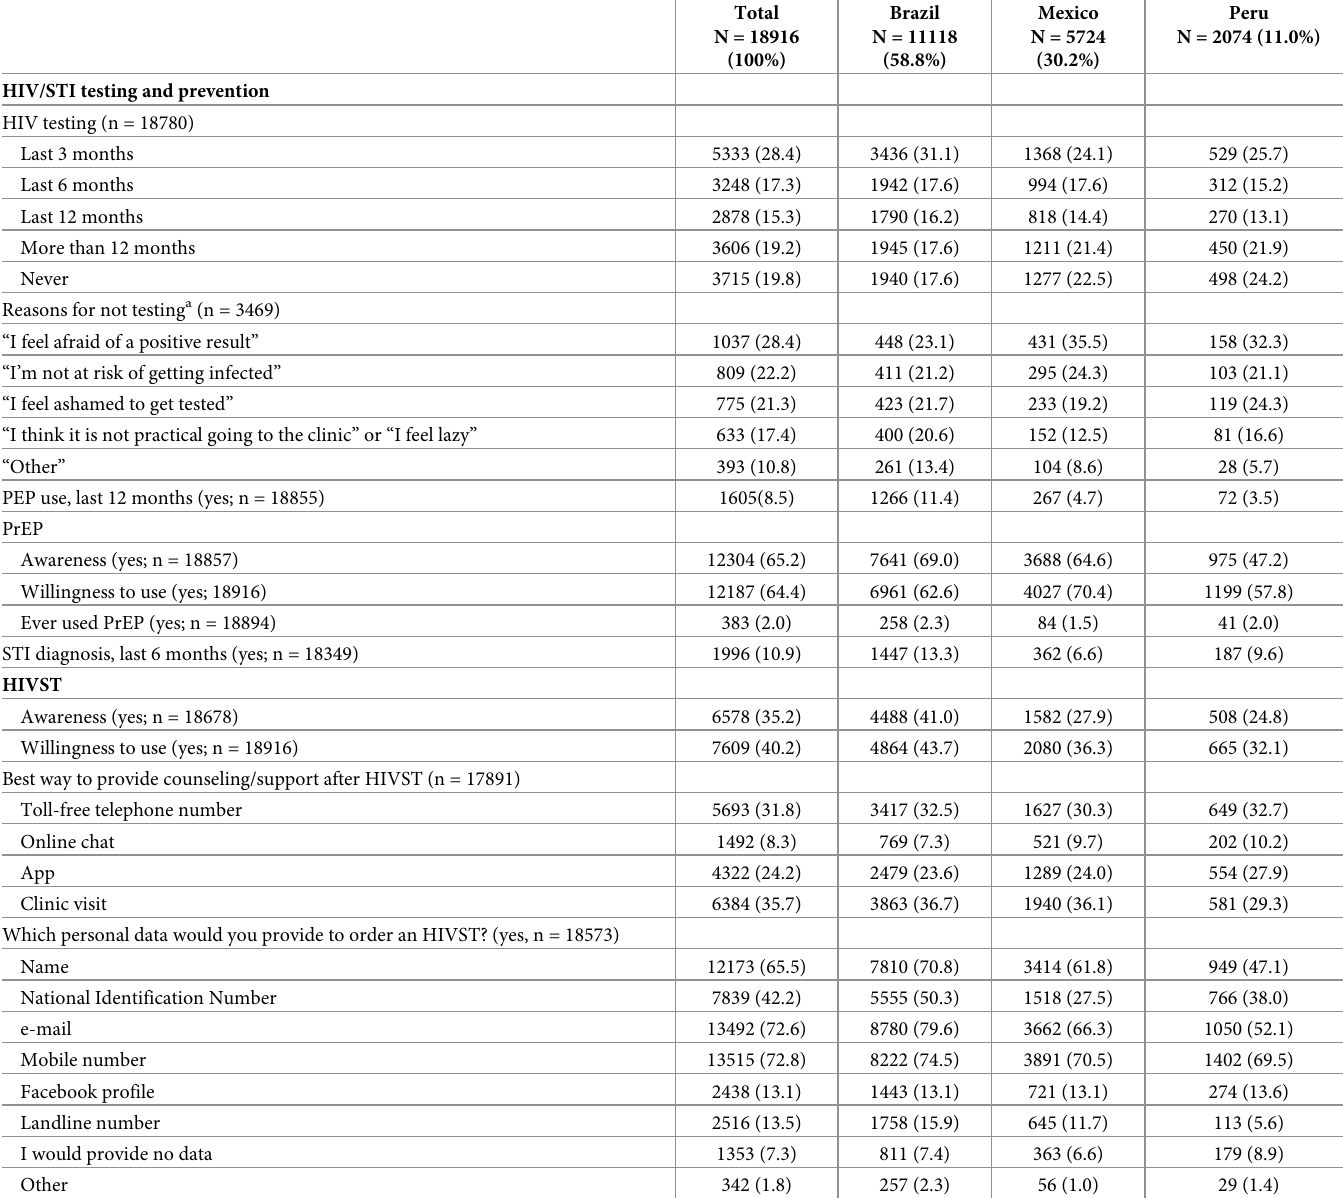
Table 2. HIV/STI testing and prevention, including HIVST among MSM from Brazil, Mexico, and Peru,